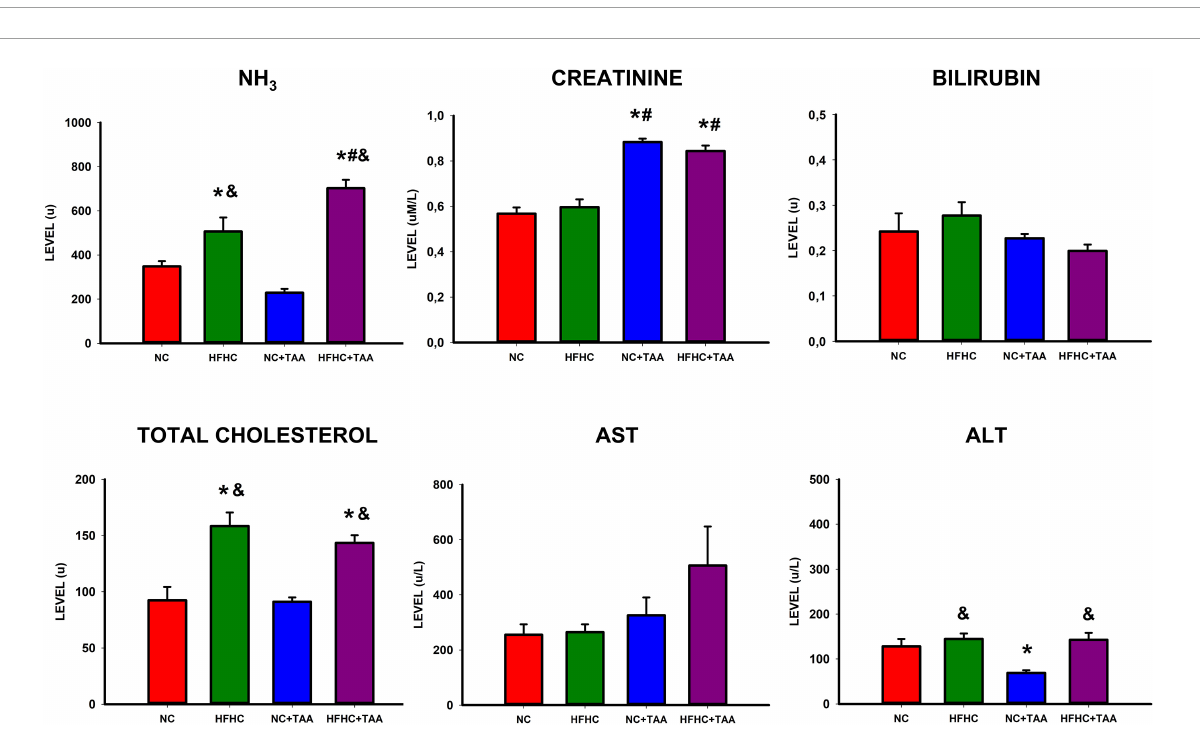
FIGURE4 Biochemical assessment in plasma. Bars charts (mean ± SEM) represent levels of ammonia (NH 3 ), creatinine, bilirubin, total cholesterol, aspartate aminotransferase (AST), and alanine aminotransferase (ALT) (u) compared through a one-way ANOVA followed by Tukey’s test (*comparison with NC, # comparison with HFHC, & comparison with NC + TAA; * #& p <